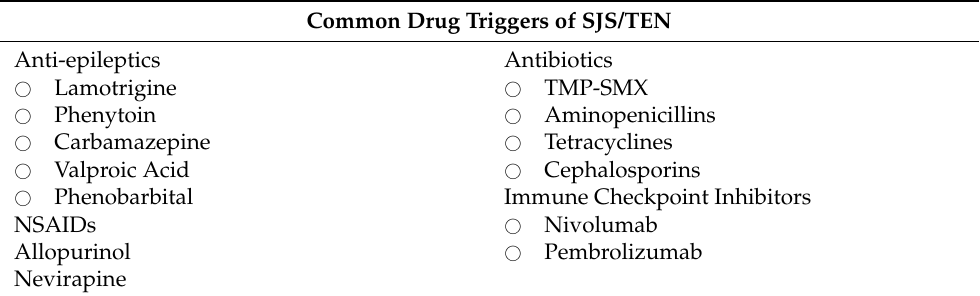
Table 2. Common drugs implicated in the pathogenesis of